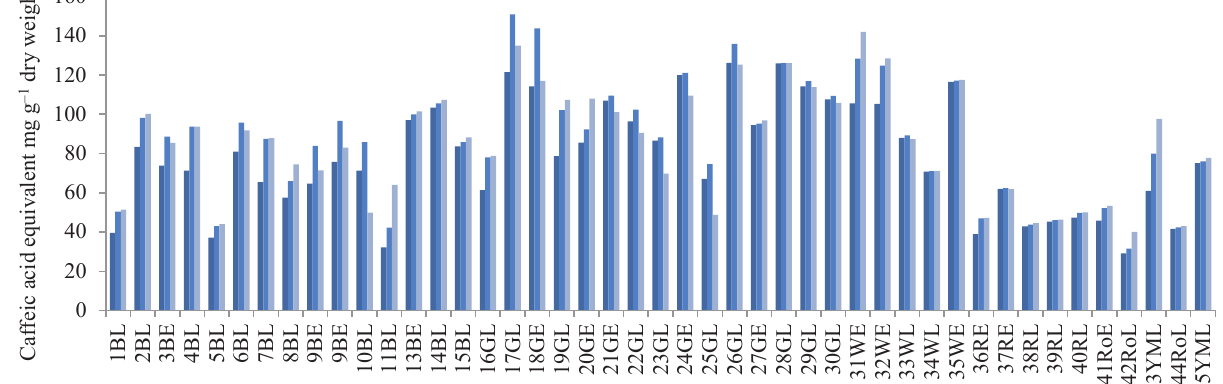
Figure 1 Changes in polyphenol content (caffeic acid equivalent mg·g –1 dry